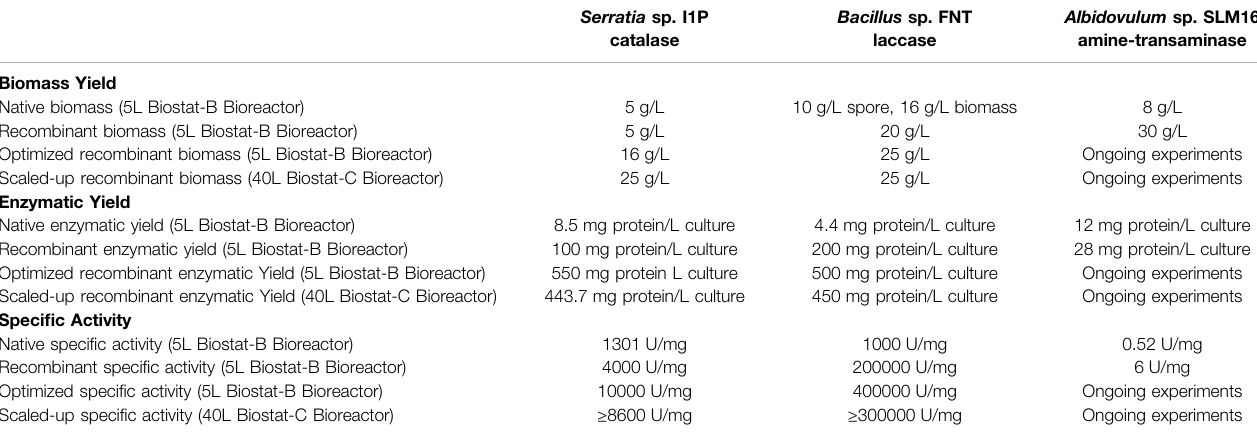
TABLE 2 | Comparison of native and recombinant enzyme